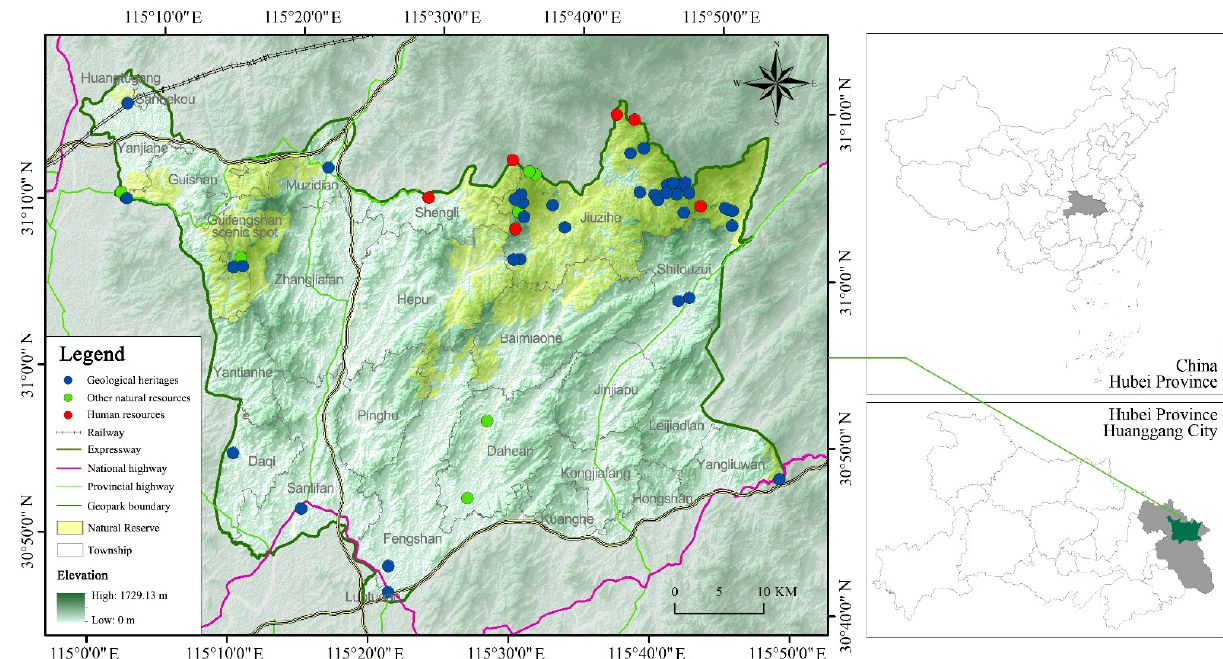
Figure 2. Geographical location of Huanggang Dabieshan UGGp.